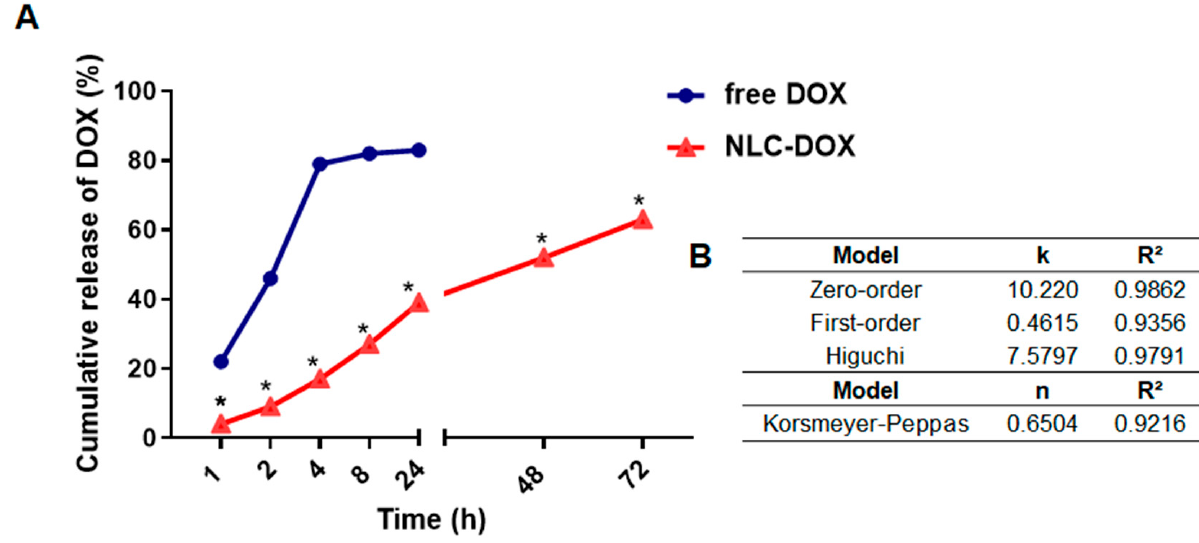
Figure 3. In vitro drug release profile of DOX from NLC-DOX and free DOX ( A ). Kinetic models applied to the release of DOX from NLC-DOX ( B ). * p < 0.0001. Data were presented as mean ± SD (n = 3). Abbreviations: DOX, doxorubicin; NLC, nanostructured lipid carrier; k, kinetic con- stant; n, diffusion exponent.